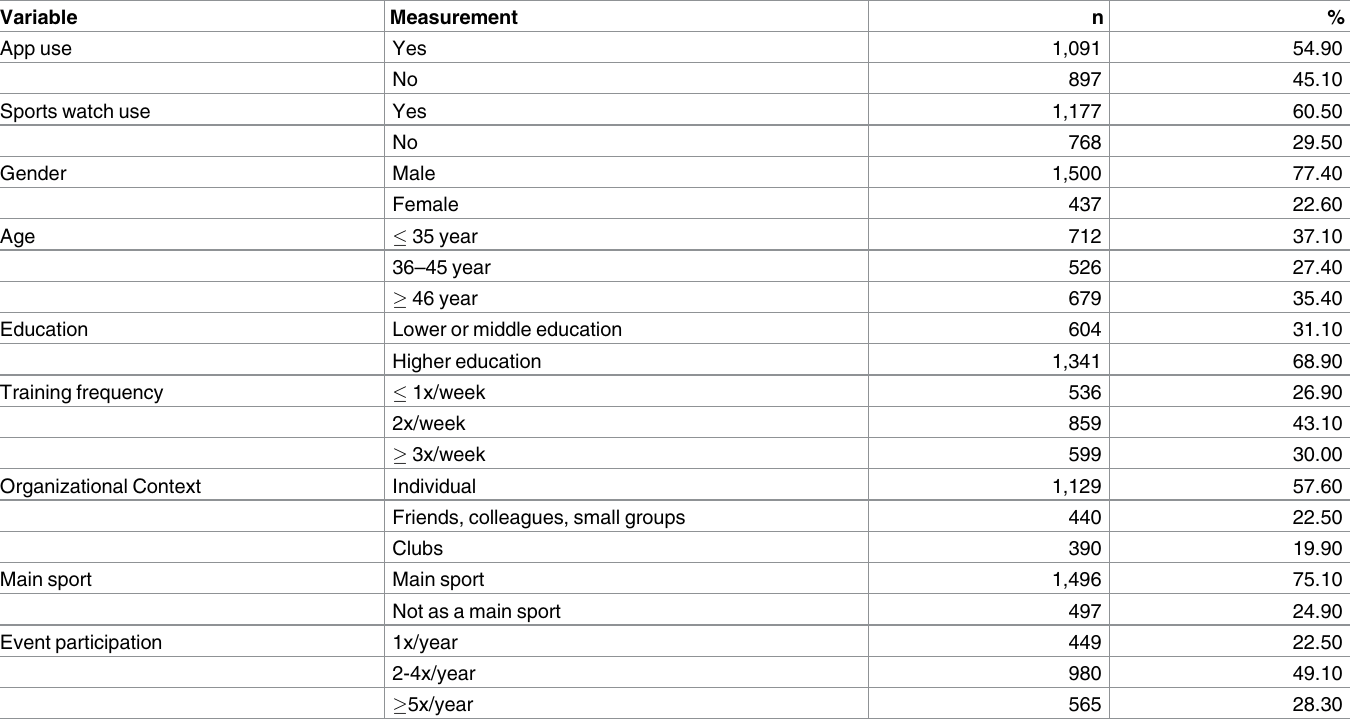
Table 1. Overview, measurements, and descriptive statistics of the dependent and independent